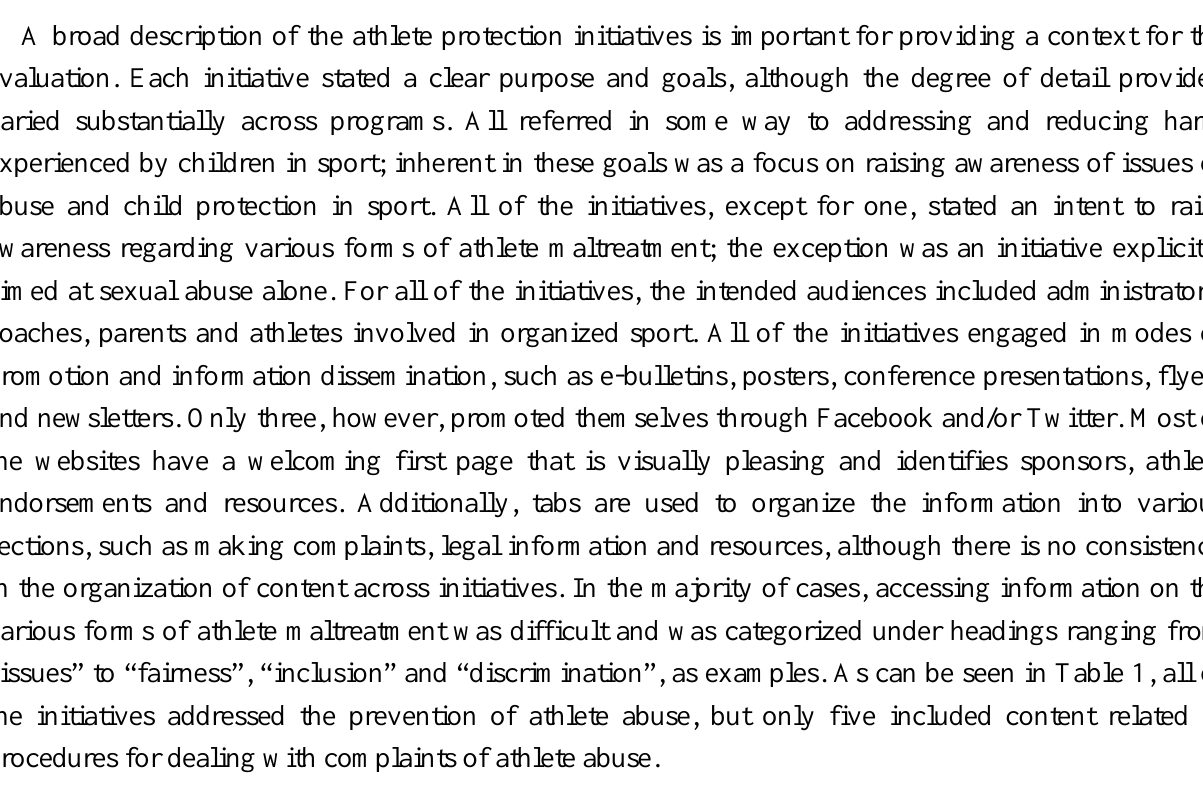
Table 1. Goals and means to achieve goals across